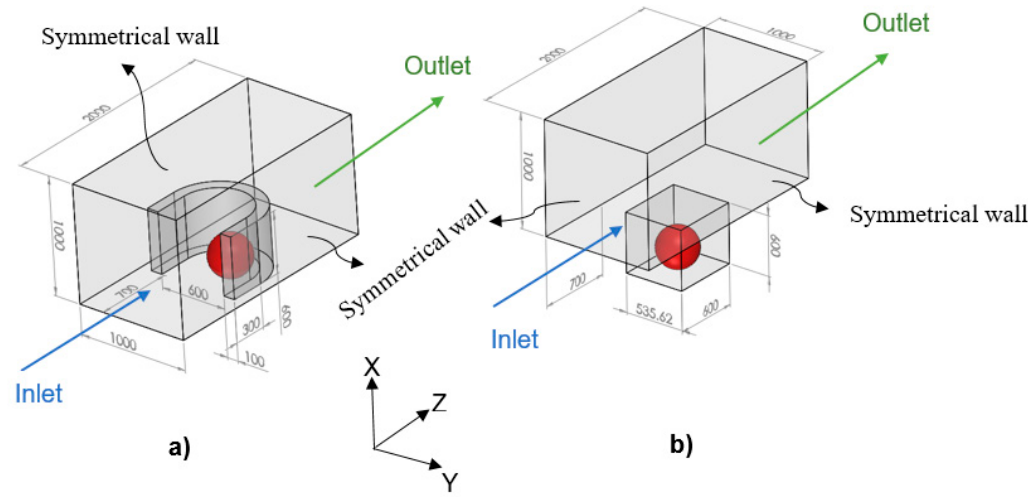
Figure 2. Tumor spheroid (the objects in red) in a microchannel containing: ( a ) A U-shaped barrier; ( b ) A microwell trap. The dimensions are in micrometer.